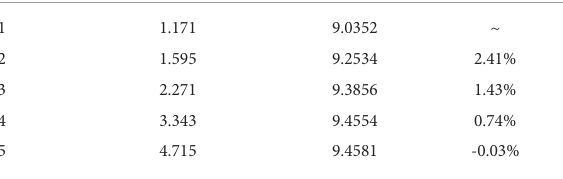
TABLE 3 Grid independence veri fi cation